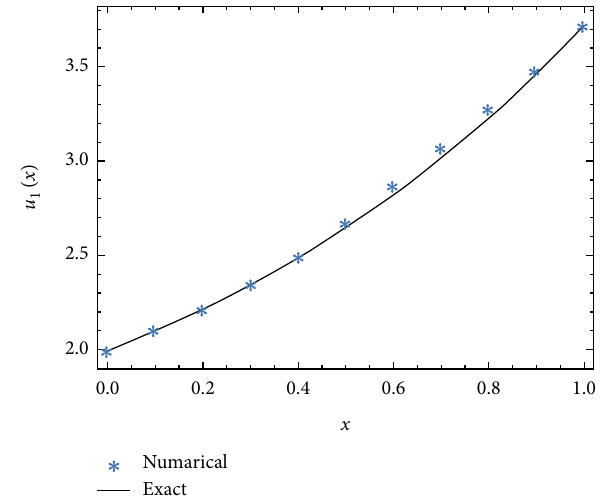
using Algorithm 1 𝑢 1